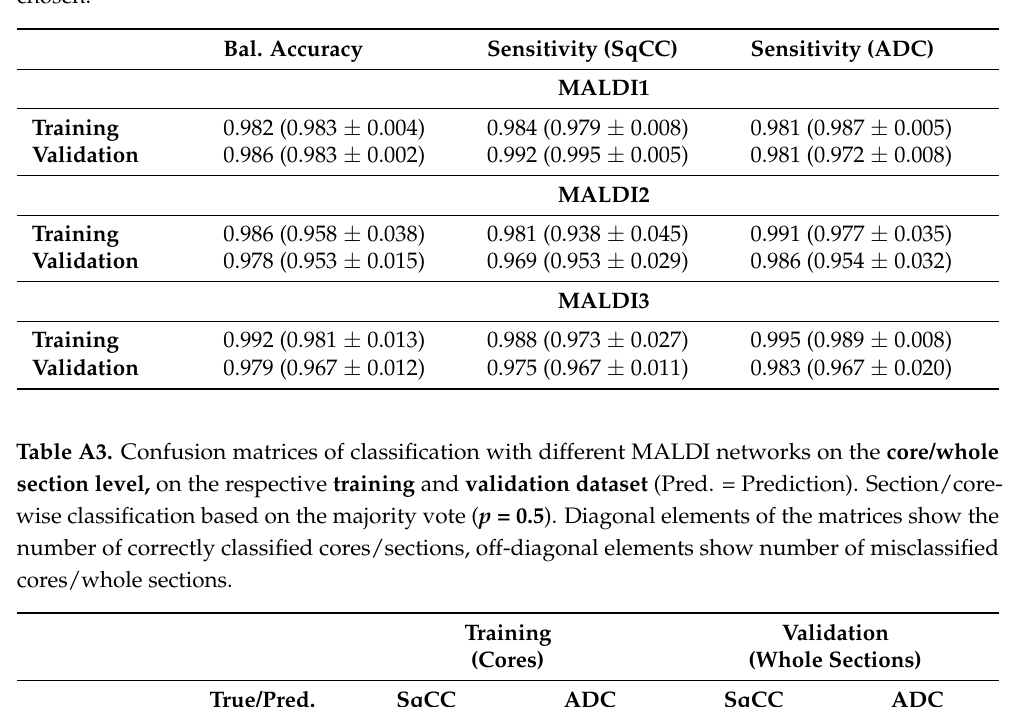
Table A2. Evaluation of classification with different MALDI networks on the spectral level , on the respective training and validation dataset. Balanced accuracy (Bal. accuracy) is the arithmetic mean of the sensitivities of both classes. Note that in a two-class classification problem, the sensitivity of one class corresponds to the specificity of the other. The mean and standard deviation of five identical training processes are displayed in brackets. The network with the highest validation accuracy was chosen.